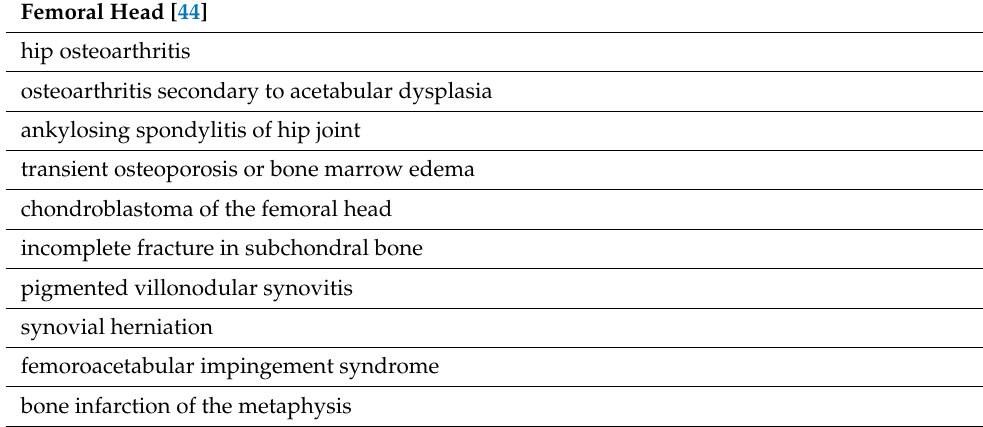
Table 2. Differential diagnosis of AVN of the femoral head.